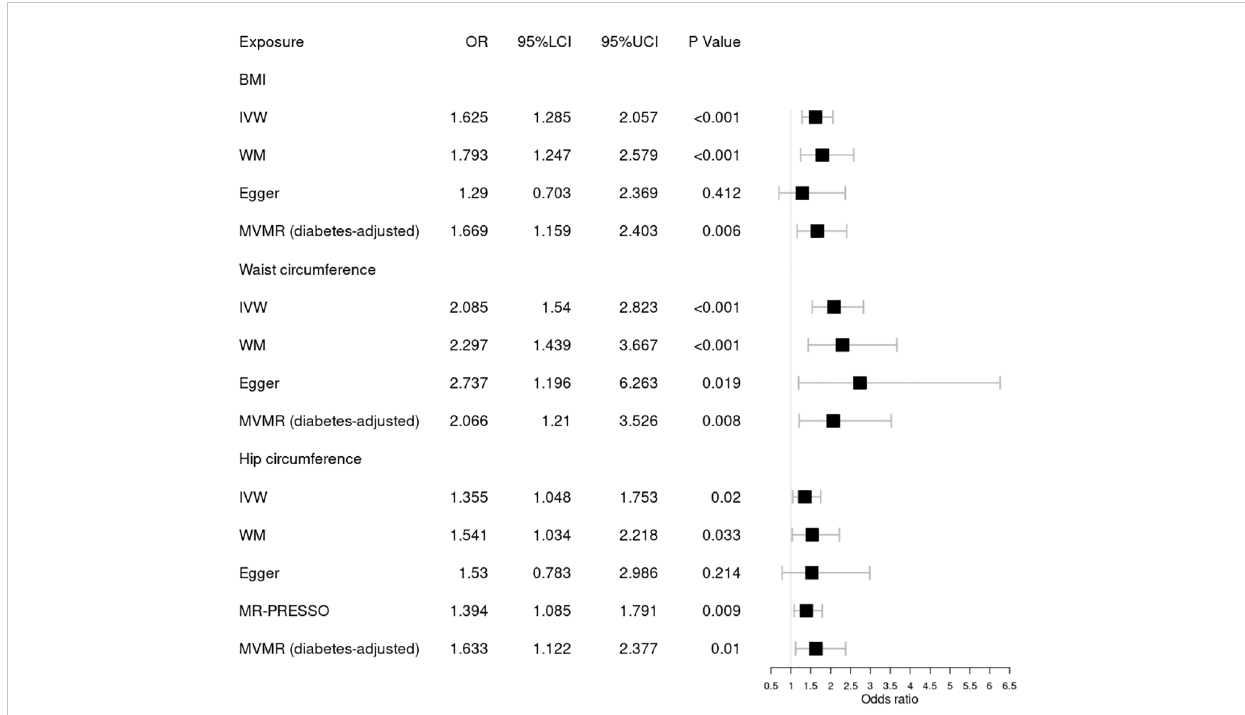
FIGURE 3 Forest plot of Mendelian randomization results of obesity effect on background DR. BMI, body mass index; IVW, inverse variance weighted; Egger, MR – Egger; WM, weighted-median; MR-PRESSO, the outlier-corrected MR pleiotropy residual sum and outlier results (one signi fi cant outlier, SNV: rs35506085); MVMR, multivariable Mendelian randomization; 95% LCI, lower limit of 95% CI; 95% UCI, upper limit of 95%